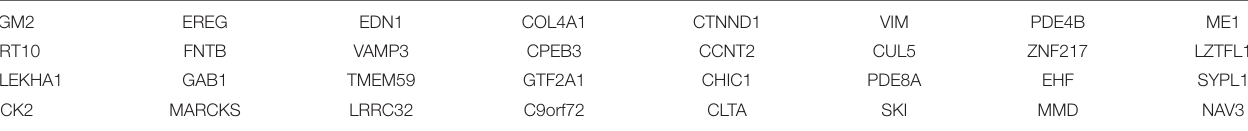
TABLE 4 | Target gene list obtained from three